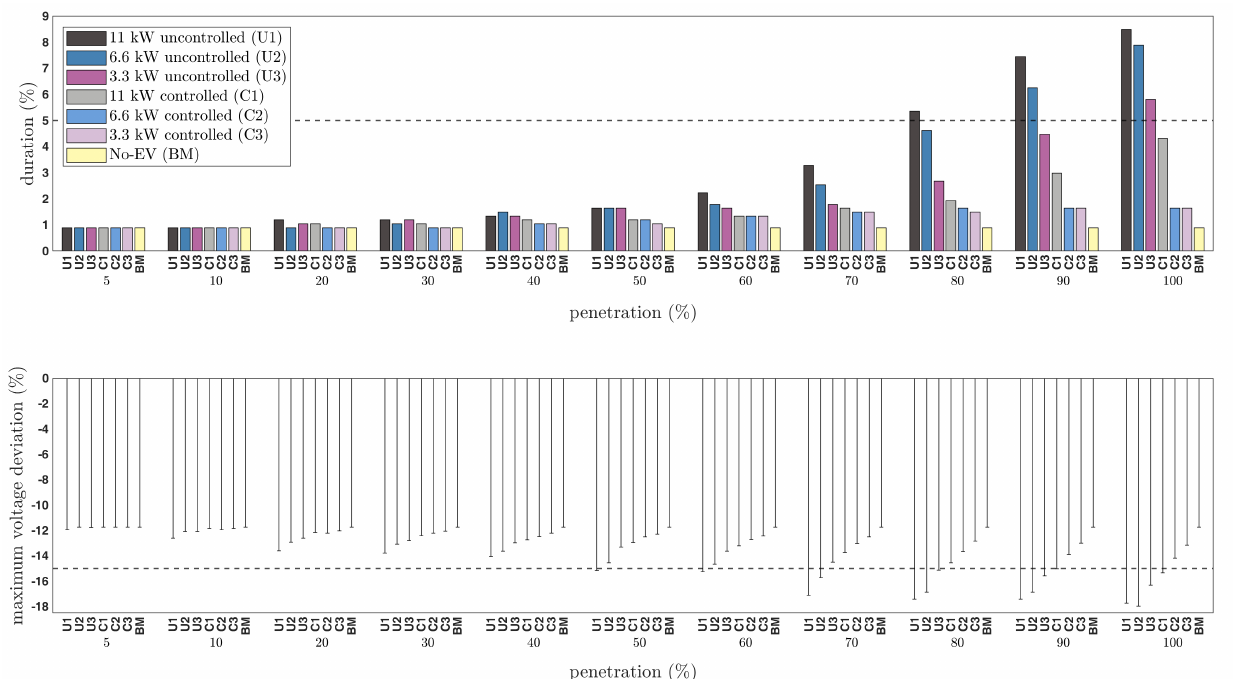
Figure 4. Maximum duration of the rms voltage deviation below the − 10% threshold ( top ), minimum voltage deviation ( bottom ) for the benchmark case (BM), the uncontrolled (U1–U3) and controlled (C1–C3) scenarios. The dashed lines show the threshold limits defined in the EN50160